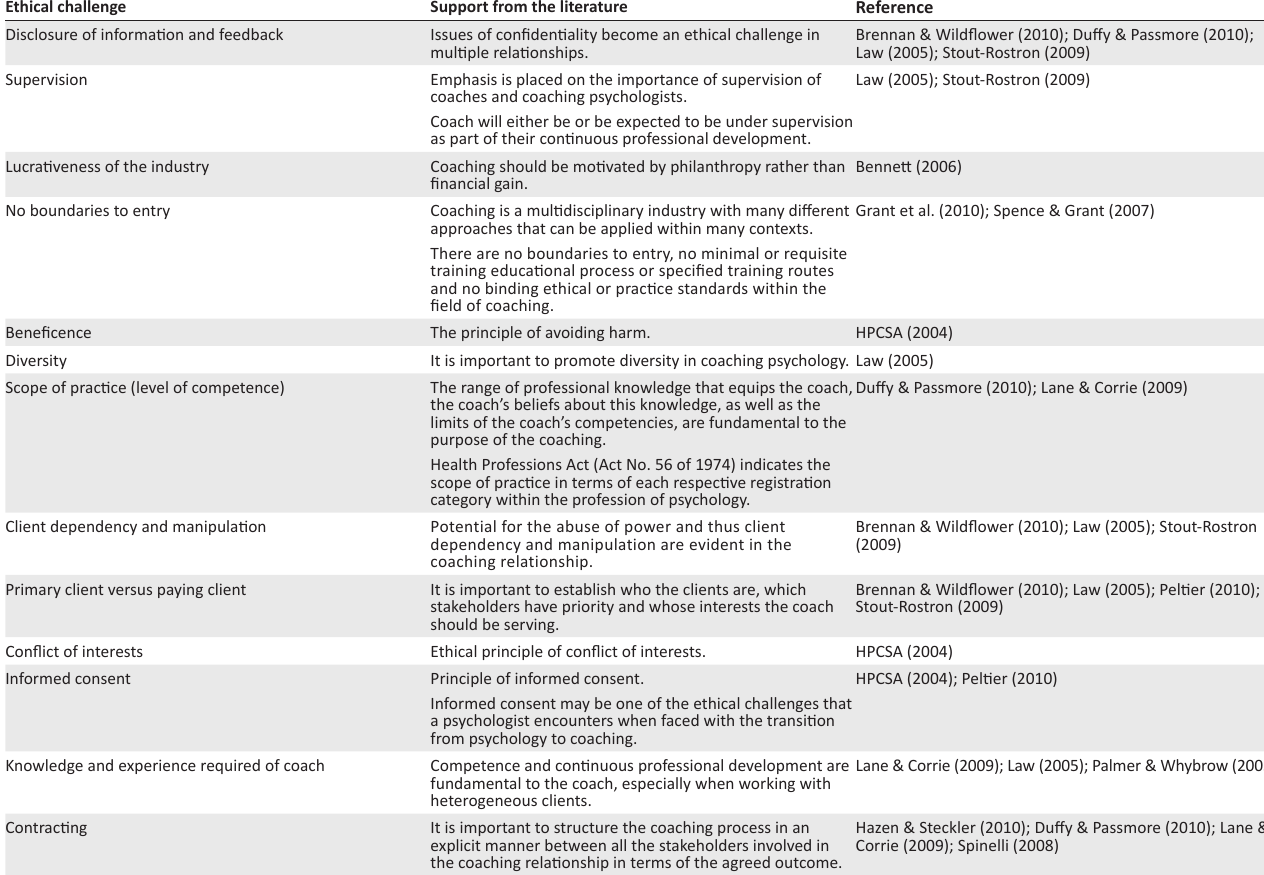
TABLE 3: Ethical challenges as identified and supported by coaching psychologists in South